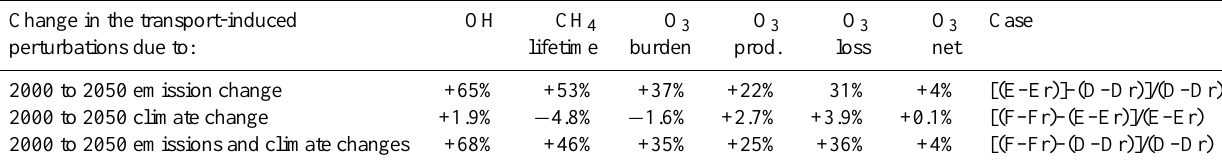
Table 5. Impact of changes in emissions and in climate on the perturbation of the global tropospheric chemistry by the transport emissions. “O 3 prod.”, “O 3 loss” and “O 3 net” refer to the O 3 chemical production, O 3 chemical loss and O 3 chemical net production, respectively. The r subscript letter refers to 5% reduction of transport emissions. See Table 2 for the definition of the D, E and F